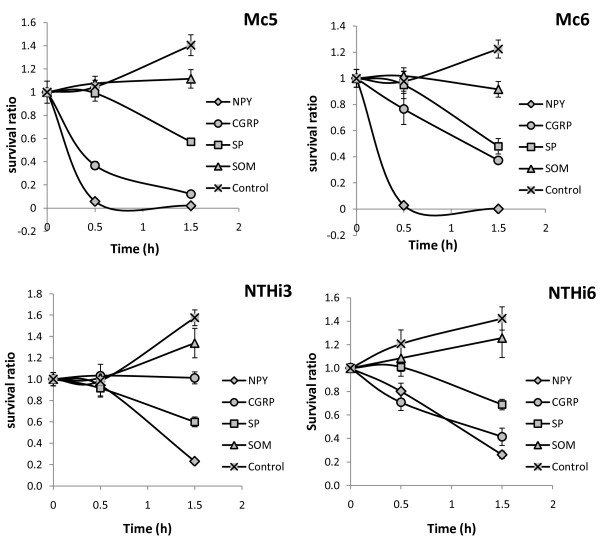
Neuropeptide-mediated killing ofM. catarrhalis(Mc) and nontypeableH. influenzae(NTHi). Bacteria at ~ 2 × 106 CFU/ml were incubated at NaPB - 1% BHI (v/w) containing 100 μM concentration of NPY, CGRP, SP, and SOM for 0.5 and 1.5 h. Serially diluted aliquotes were plated on BHI agar. The data are expressed as mean survival ratios ± SEM from two independent experiments performed in triplicate.